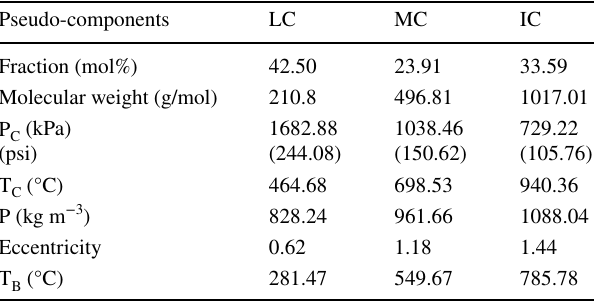
Table 2 PVT data used in this study, where LC, MC, and IC are defined as the light, mobile, and immobile pseudo-components, respectively Pseudo-components